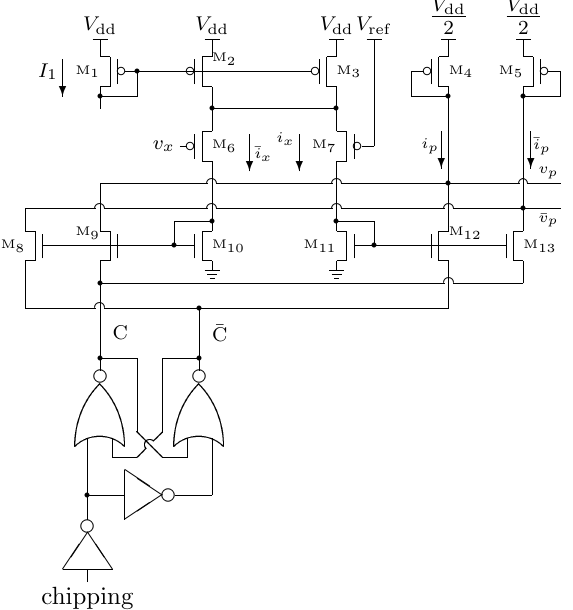
Figure 6. Modulator circuit